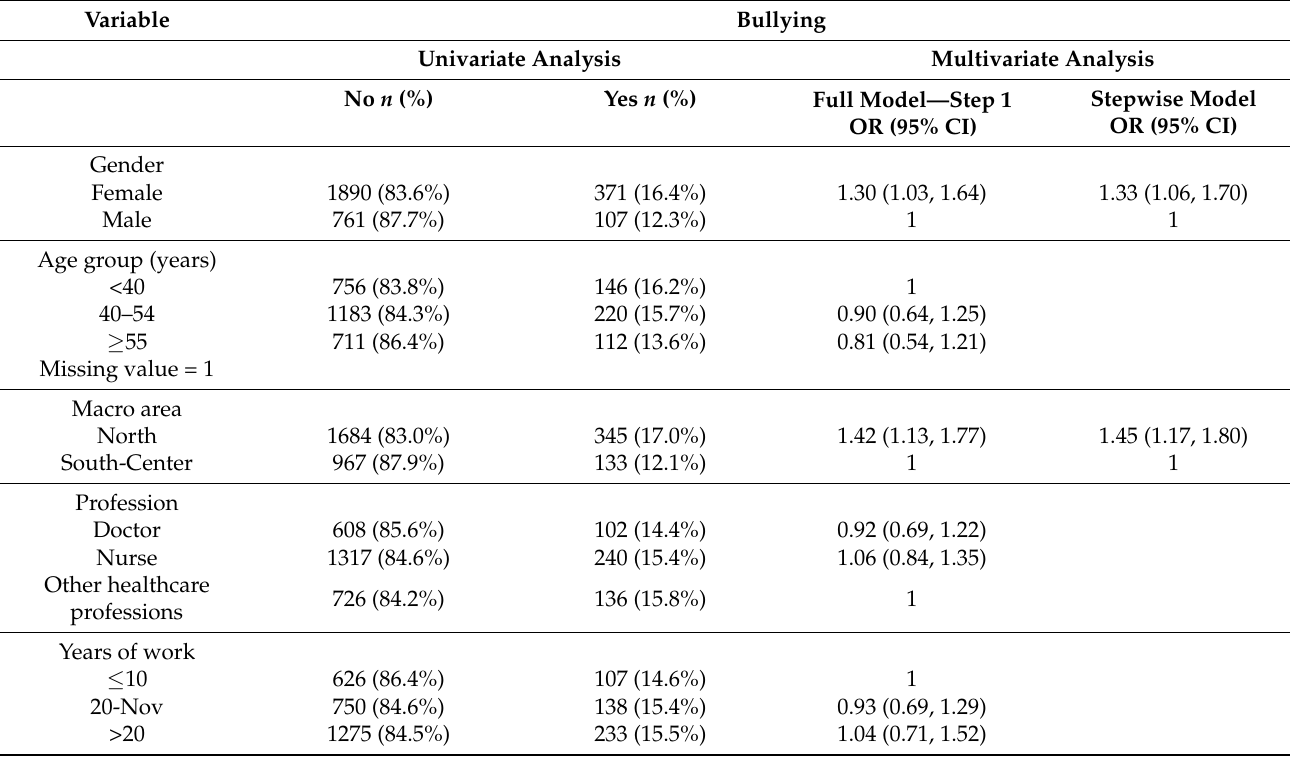
Table 2. Being a victim of bullying: univariate and multivariate